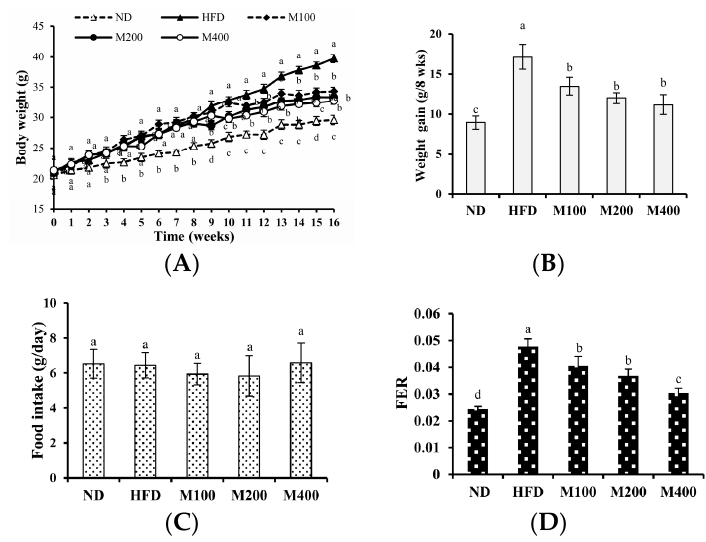
Figure 1. Effect of MFGM on the body weight gain in HFD-fed mice. Mice were fed with a normal chow diet (ND), a high-fat diet (HFD), high-fat diet supplemented with MFGM at 100 mg/kg BW (M100), 200 mg/kg BW (M200) or 400 mg/kg BW (M400) for eight weeks. Changes in the ( A ) body weight; ( B ) body weight gain; ( C ) food intake and ( D ) food efficiency ratio (FER). FER = Body weight gain (g)/food intake during trial period (g). Means ± SE ( n = 6). Mean values with different letters indicate statistical significance ( p < 0.05).